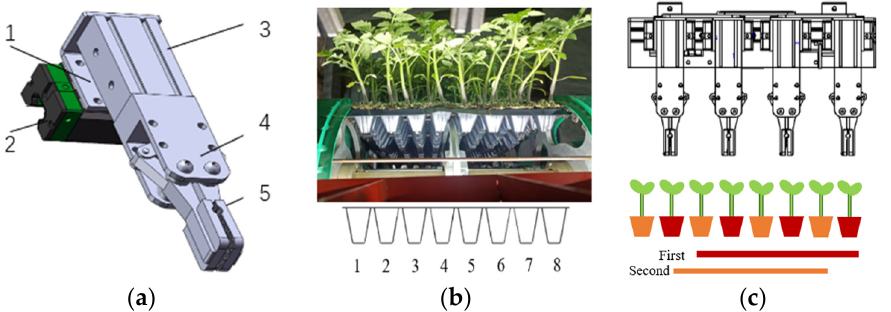
Figure 2. Principle of seedling picking. ( a ) End effector; ( b ) Working condition; ( c ) Picking Logic. 1. Support plate, 2. Slide rail, 3. Picking Cylinder, 4. Driving mechanism, 5. Fixture.